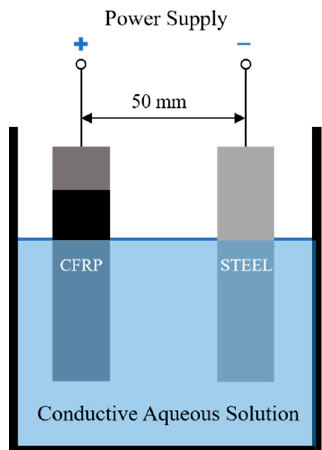
Figure 2. The schematic diagram of the electrochemical catalytic reaction setup.